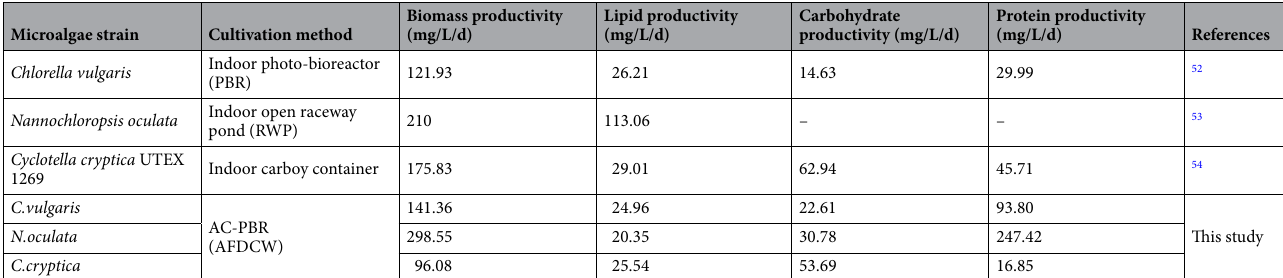
Table 1. Comparison of biomass and constituent productivity of microalgal strains cultivated in AC-PBRs in this study versus performance in common PBRs as reported in the literature.